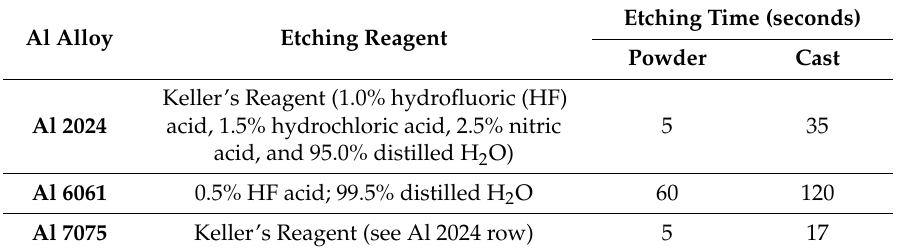
Table 3. Chemical etching reagents and etching times for each of the conventionally cast as well as rapidly solidified aluminum alloys considered herein: Al 2024, Al 6061, and Al